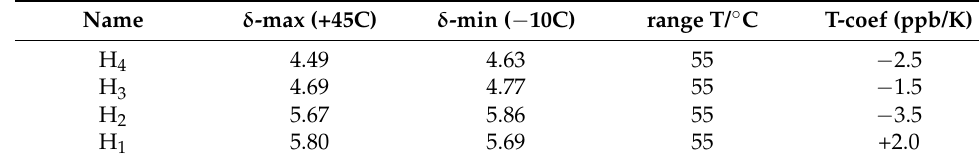
Table 2. Temperature coefficients of the H N protons of compound 3.